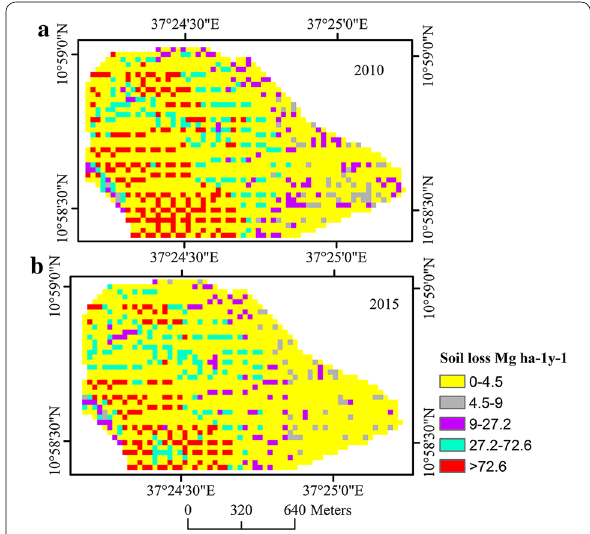
Fig. 4 Soil loss rate map of the study area in 2010 ( a ) and 2015 ( b )